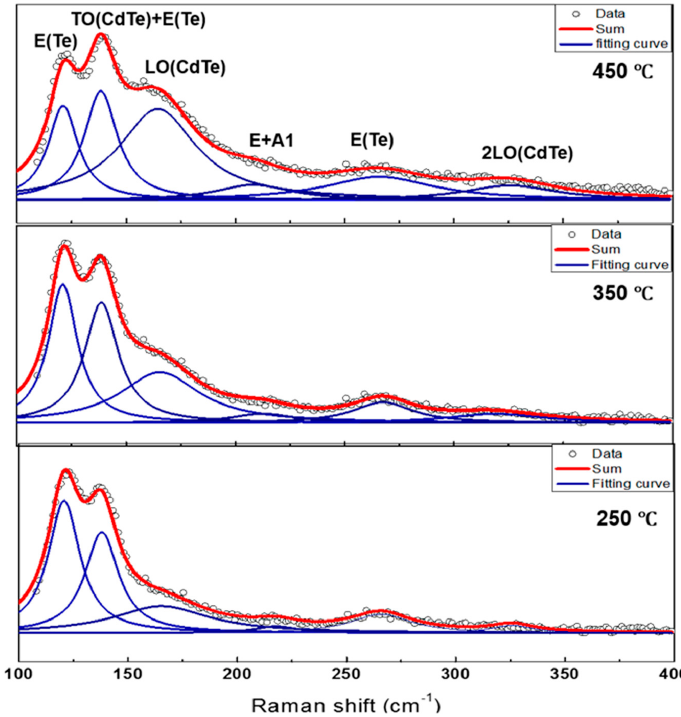
Figure 4. Raman spectrum (fitted using Lorentzian functions) of the CdTe films under different substrate temperature. substrate